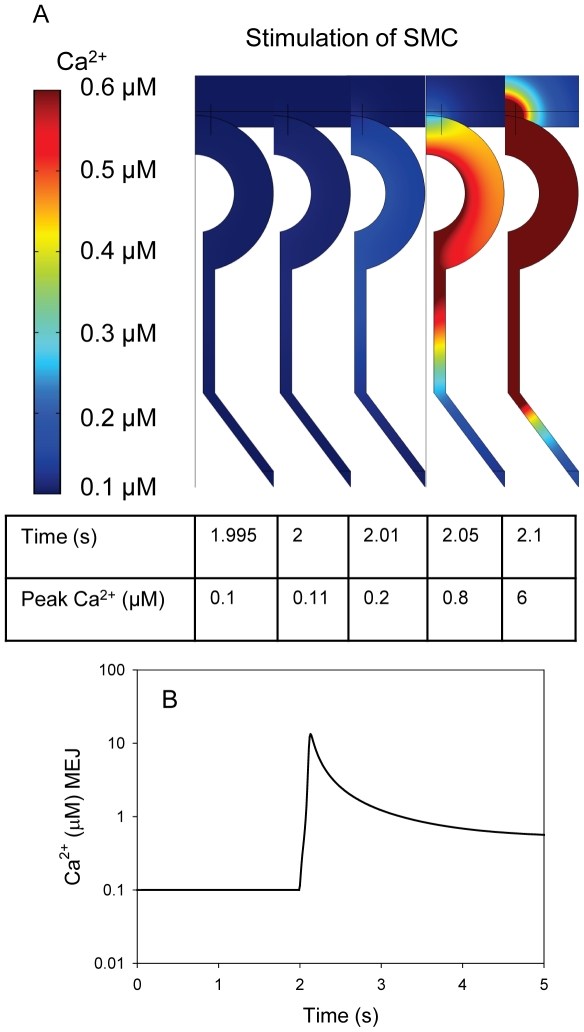
Model 2, the MEJ is a sensor of the adjacent cell.A) The changes in Ca2+ concentration in the protrusions following an increase in the boundary level of IP3 in the SMC from 0.1 to 0.4 µM. The local Ca2+ cloud in the SMC is due to diffusion of Ca2+ from the EC/MEJ through the gap junction. The concentration of Ca2+ in the protrusion is shown at the indicated time points. Below the bar with the time points are the peak concentrations of Ca2+. The IP3 level was increased at time 2 s in the SMC. B) Average Ca2+ concentration in the MEJ following an IP3 increase in the SMC. When IP3 was increased from 0.1 to 0.4 µM in the SMC the Ca2+ microdomain in the MEJ was on average of 4 µM at time 2.1 s and 12 µM at time 2.14 s.